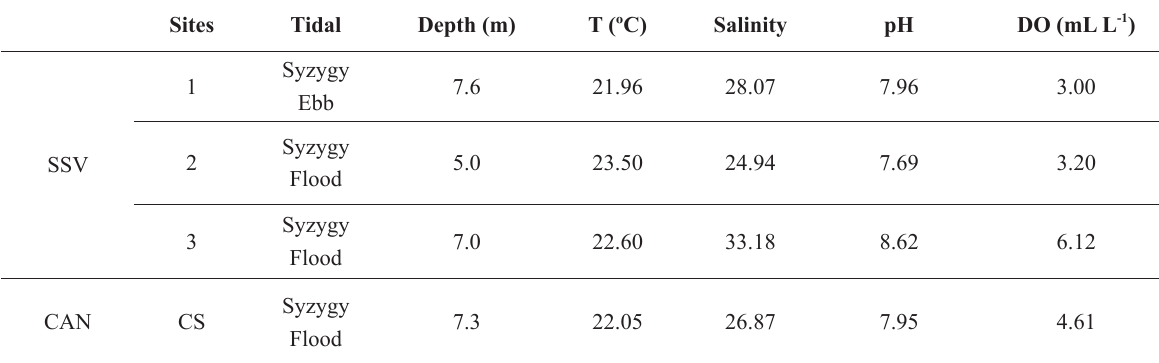
Physicochemical parameters from the water bottom of different sites in the both estuaries. CS = Cubatão